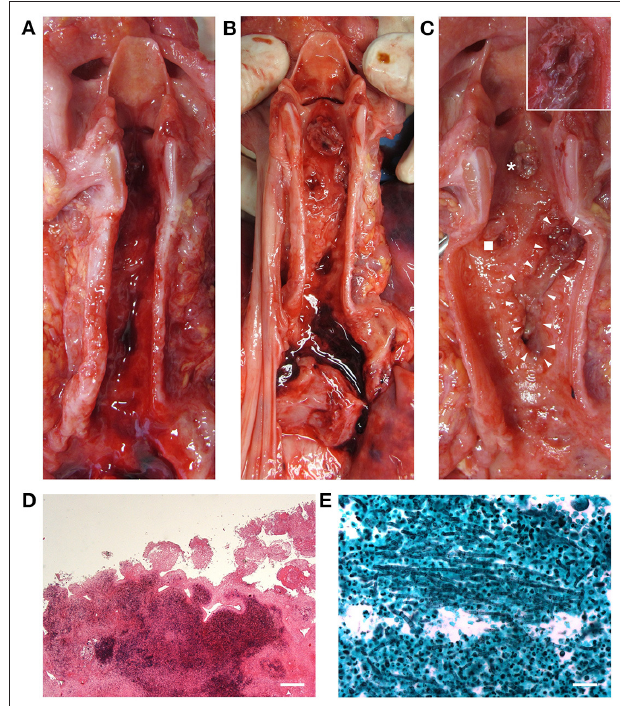
FIGURE 2 | Macroscopic examination of the laryngeal cavity and tracheal lumen. Opening of the larynx, trachea, and bronchi with evidence of blood (A) . Laryngotracheal ulcerative lesions with presence of some necrotic pseudomembranous-like features (asterisk, cricoid lesion; square, left anterolateral tracheal lesion; triangles, right anterolateral tracheal lesion) consistent with invasive Aspergillus laryngotracheitis (B,C) ; the insert in (C) shows a magnification of the site corresponding to tracheal wall perforation and thyroid artery damage. Histopathologic examination by hematoxylin and eosin of the laryngeal mucosa at the site of ulceration (transversal section), showing inflammatory infiltration and signs of tissue necrosis (Scale bar: 400 µ m) (D) . Grocott–Gomori’s methenamine silver stain showing Aspergillus branching hyphae (black) infiltrating the laryngotracheal wall in a necrotic ground (E) (Scale bar: 50 µ